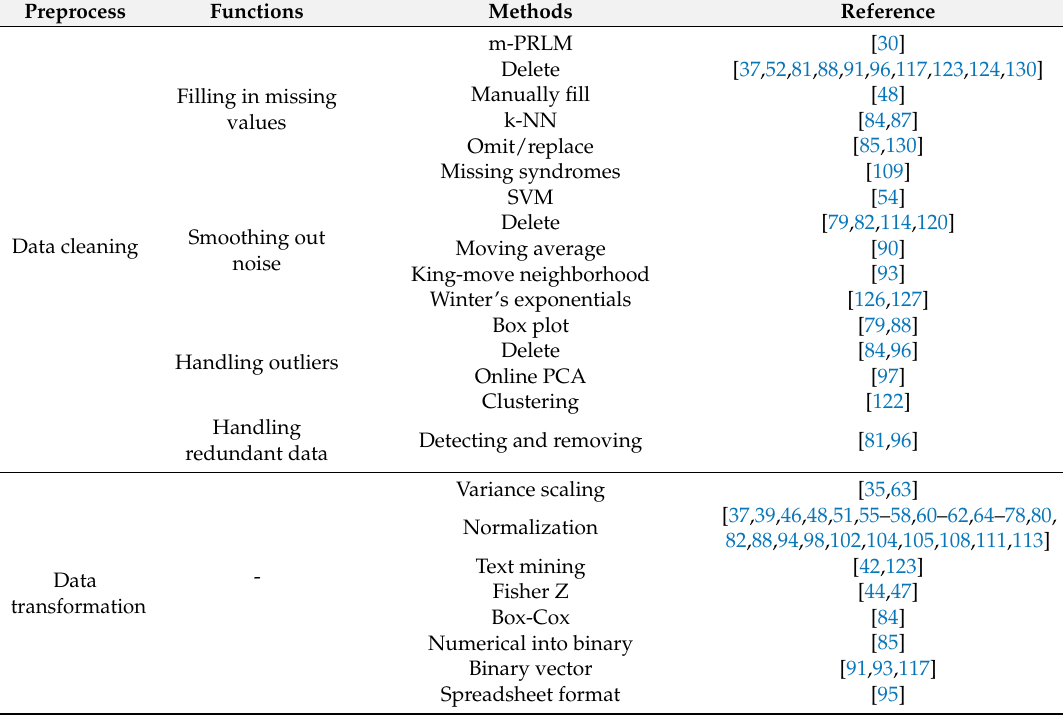
Table 7. The preprocessing techniques used in the reviewed